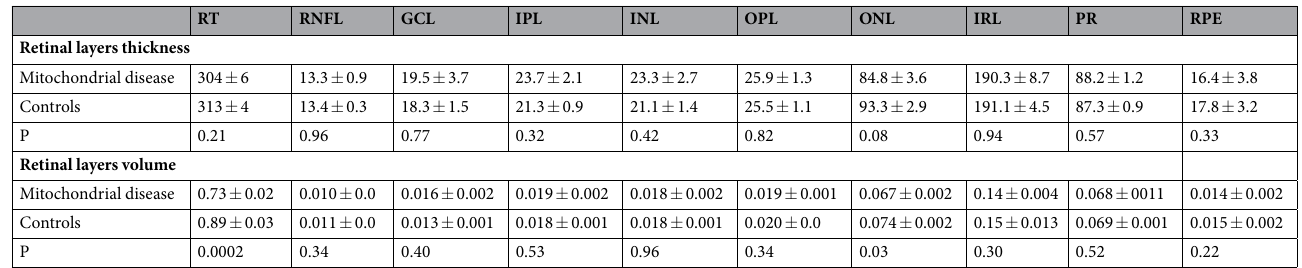
Table 2. Comparison of thickness and volume of the entire retina and of individual retinal layers between healthy subjects and patients with mitochondrial disease (mean ±